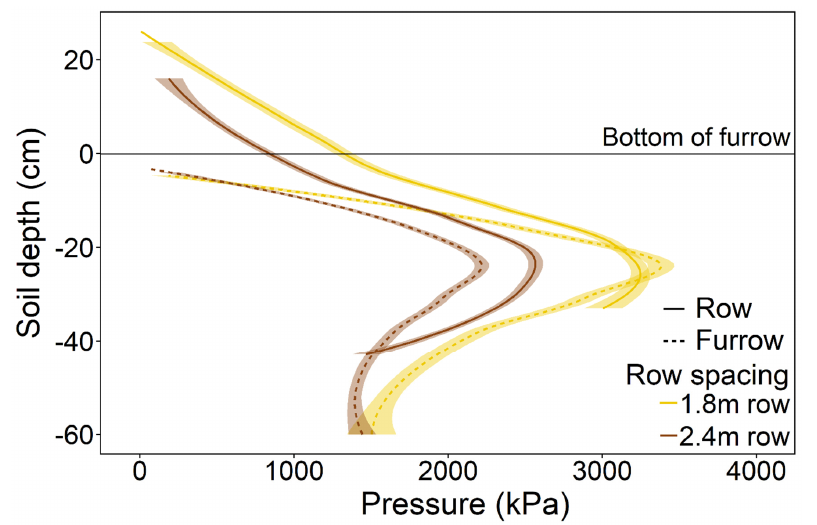
Figure 5. Depth of compaction in the soil relative to the pressure necessary to insert the probe. Measurements were made in 2020 in the furrow (dashed line) and row (solid line). The soil depth is relative to the height of the row. Plant year is the year in which the plots were planted. There was no difference in the relationship between soil depth and pressure of compaction between varieties (L01 − 299 and HoCP 04 − 838).